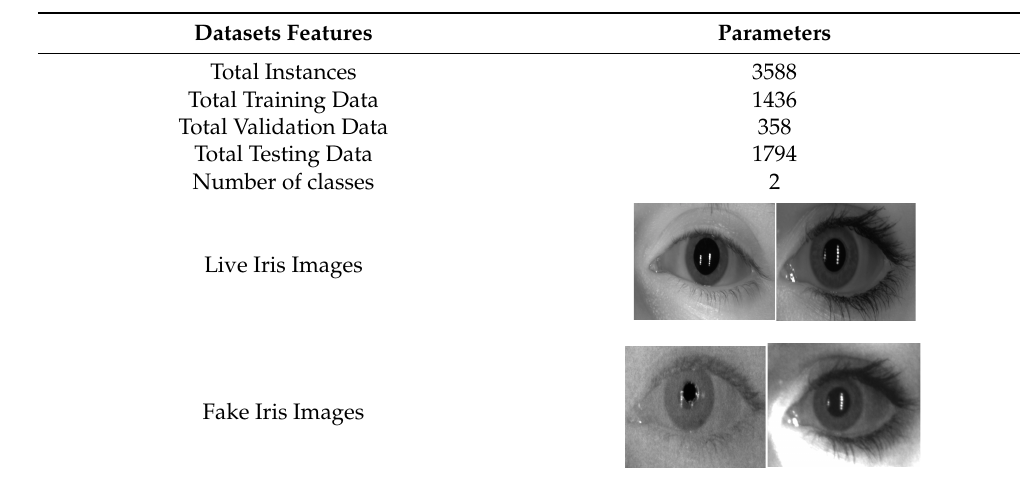
Table 1. The Clarkson dataset description.